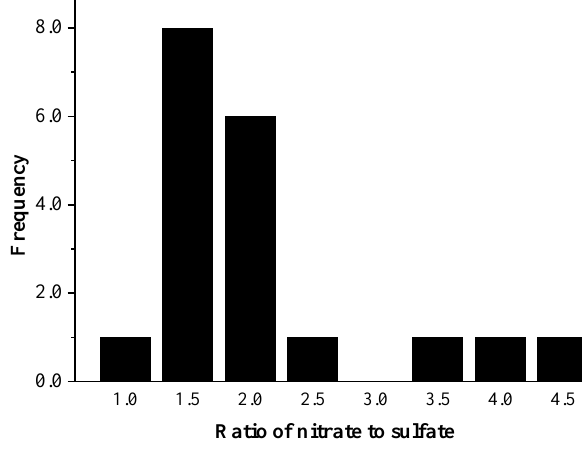
Fig.6. Frequency of the ratio of nitrate to sulfate in fresh snow. Fig. 6. Frequency of the ratio of nitrate to sulfate in fresh